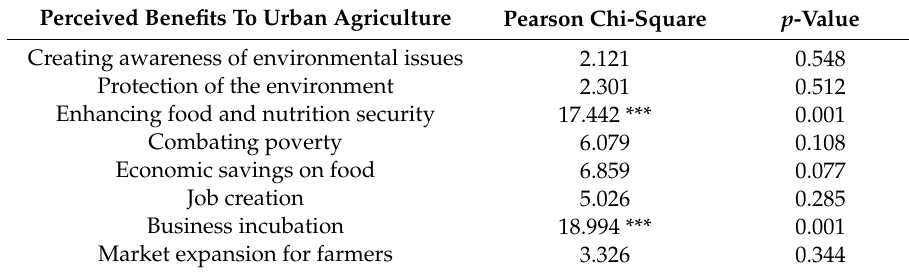
Table 9. Relationship between the perceived benefits for urban farming and the utilisation of organic waste through urban agriculture in the Durban South Basin (n =